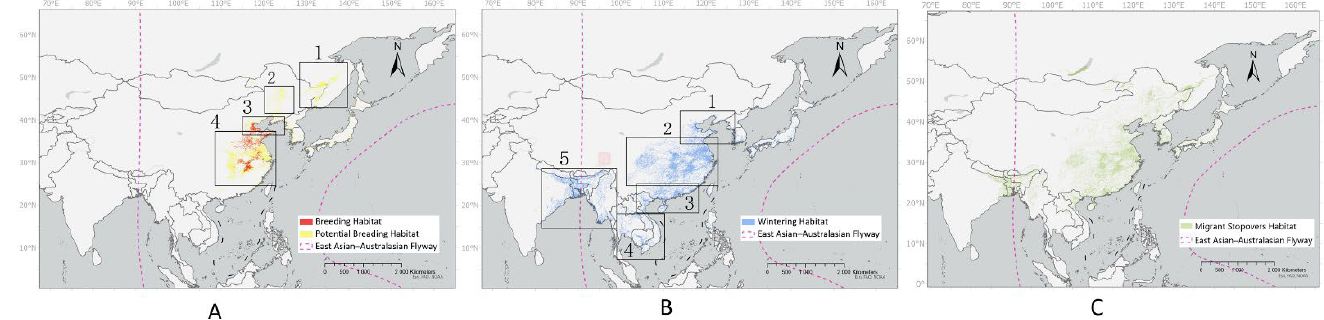
Figure 6. Suitable Habitat of Bear’s Pochard during its three life stages. ( A ) Breeding, ( B ) Wintering, and ( C ) Migratory stopover.